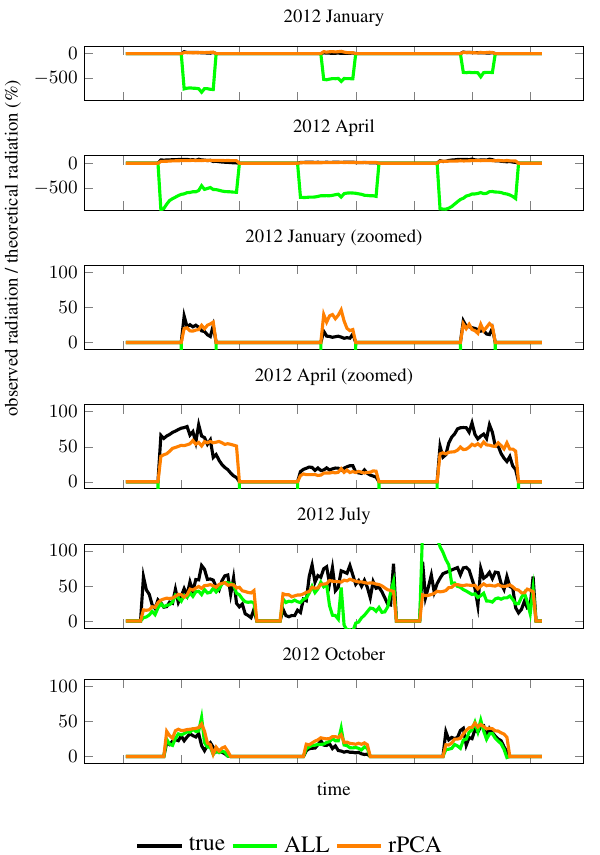
Figure 7. Visualization of nowcasting (each plot shows 3 days).